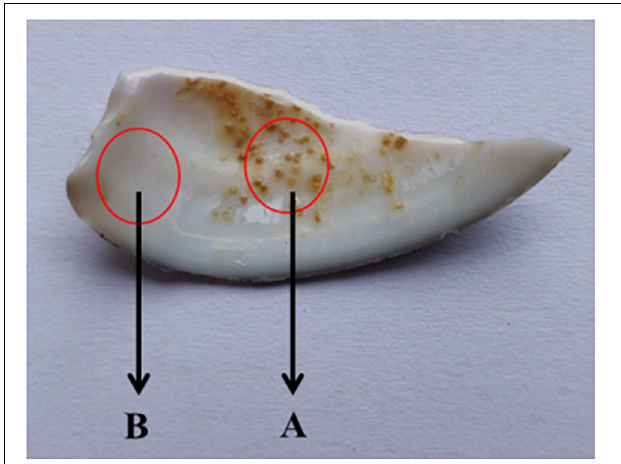
FIGURE 4 | Microscopic pictures of spots. The image below is a larger version of the picture in the red box